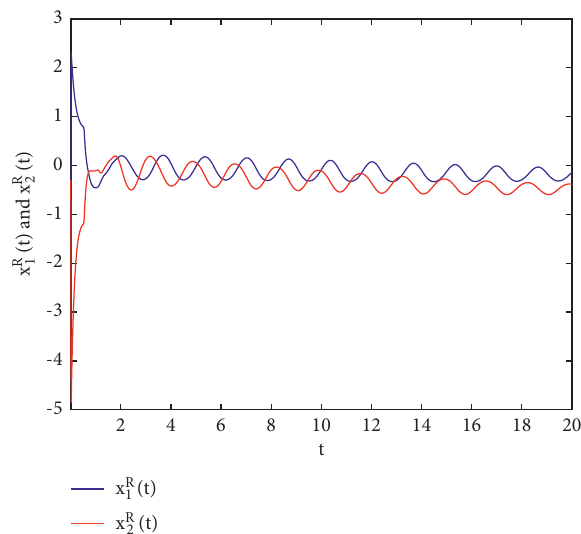
Figure 1: Real parts of the transient states of system (65).